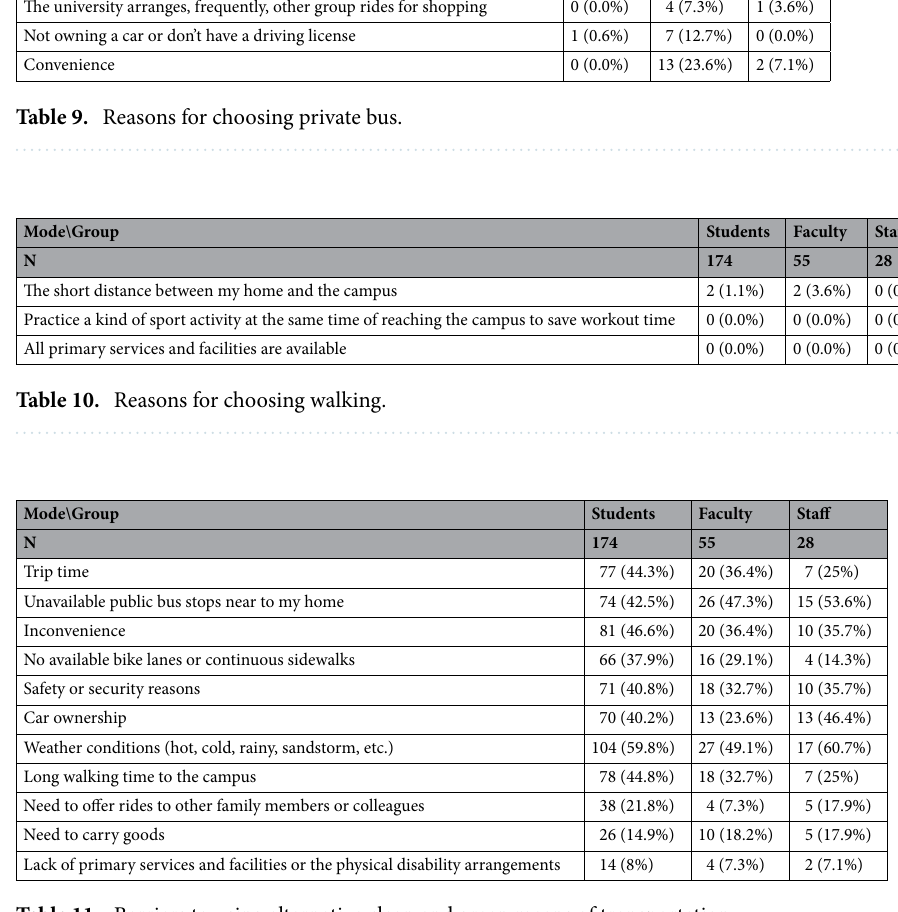
Table 11. Barriers to using alternative clean and green means of